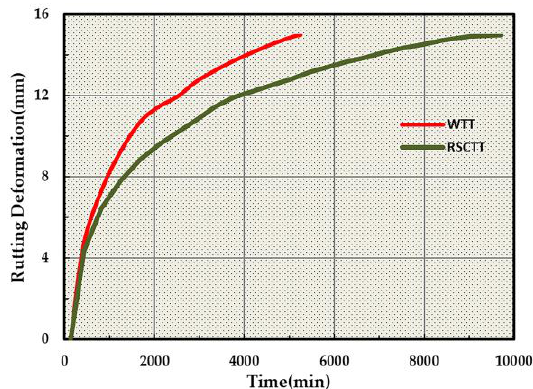
Figure 4. Deformation curve of the WTT and the RSCT test.